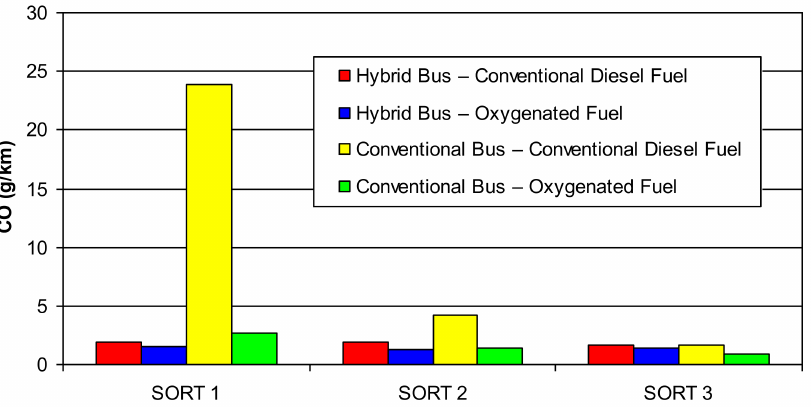
Figure 10. Comparison of CO emissions of serial hybrid and conventional city buses running on conventional and oxygenated diesel fuel, over the SORT